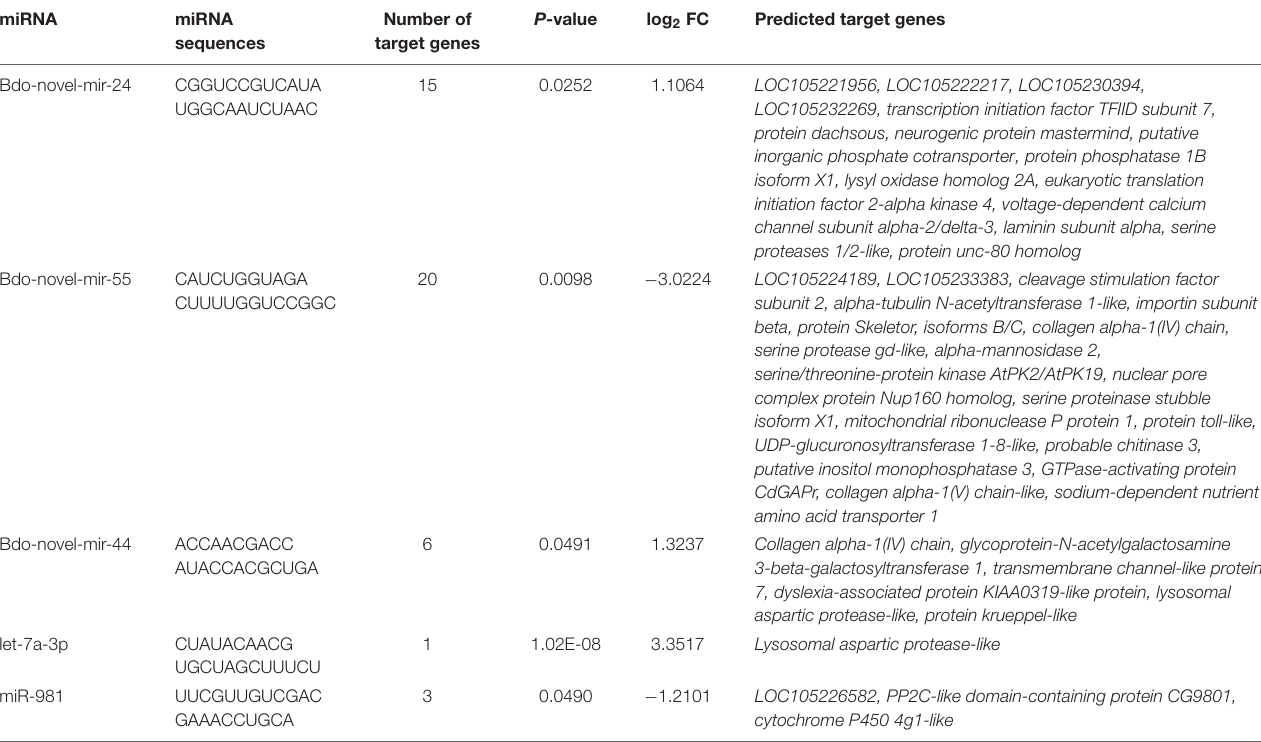
TABLE 2 | Predicted targets of five high differential expression miRNAs in pupariation of Bactrocera dorsalis .